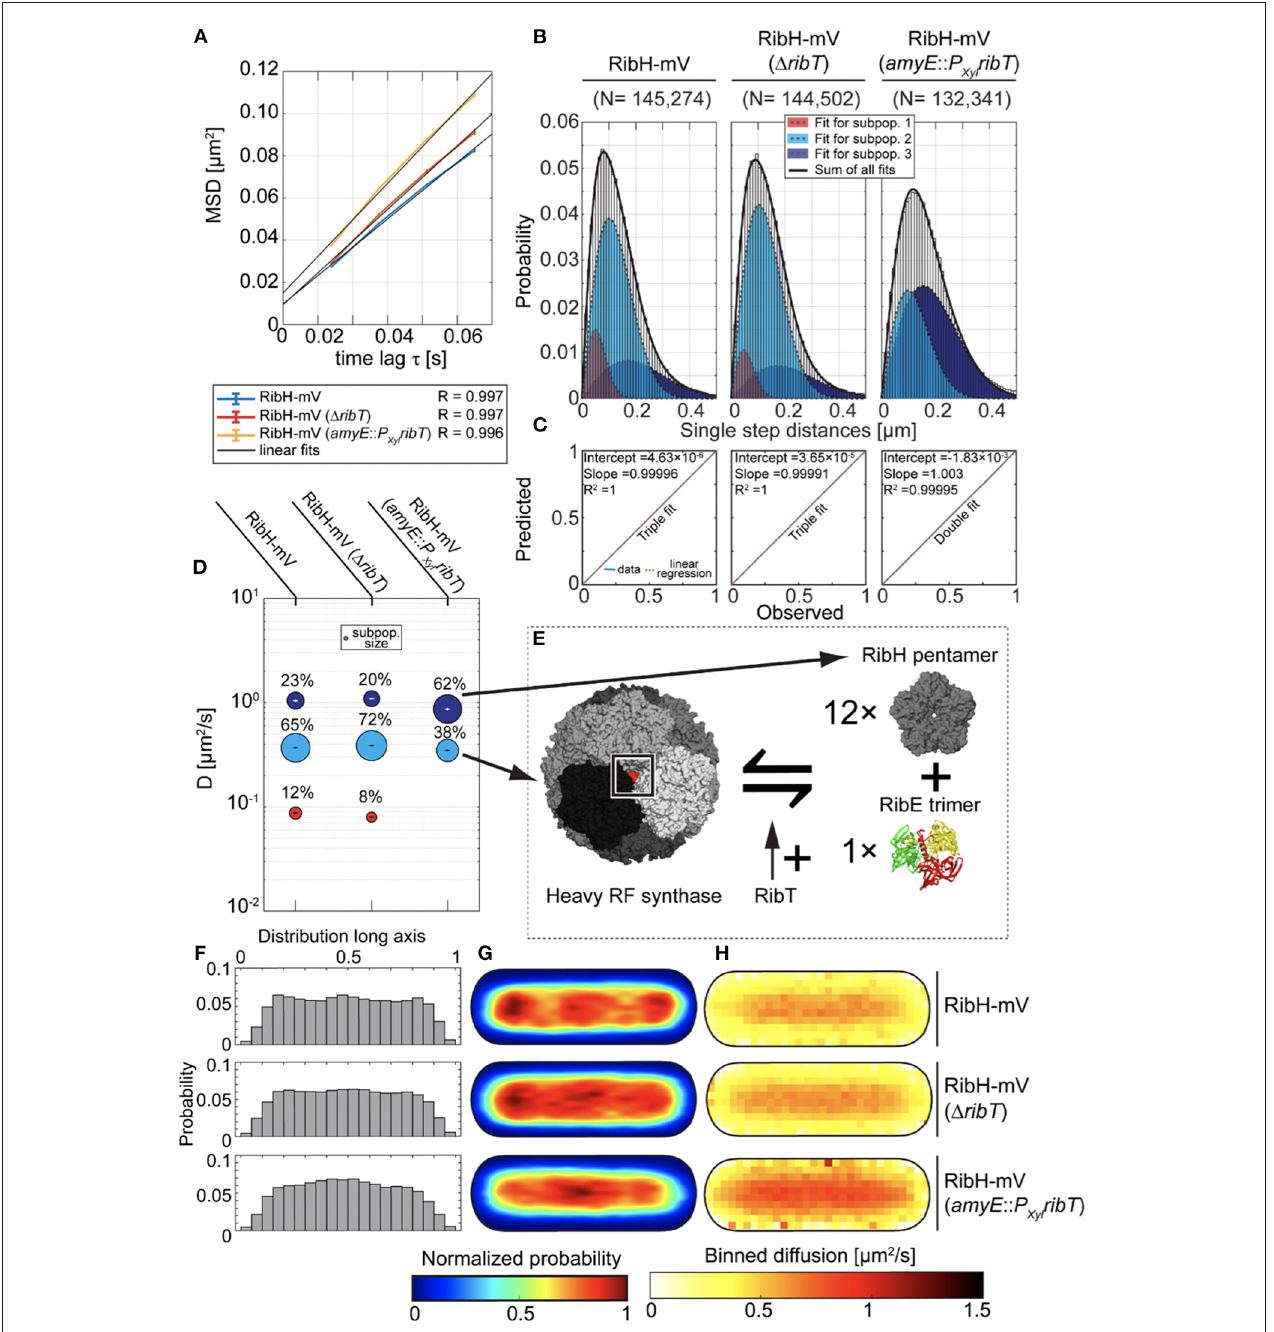
FIGURE 3 | Production of RibT from an ectopic locus in B. subtilis induces changes in diffusion of RibH-mV. (A) EAMSD vs. the time plot for three strains carrying RibH-mV either in the presence of ribT gene expressed from original locus (RibH-mV), or with ribT gene being deleted from the nucleoid (RibH-mV, 1 ribT ), or with ribT gene being expressed from an inducible, ectopic gene locus (RibH-mV, amyE :: P Xyl ribT ). (B) JD analysis of RibH-mV and RibH-mV ( 1 ribT ) SPT data using a three-component Rayleigh Mixture model, as well as RibH-mV ( amyE::P Xyl ribT ) using a two-component Rayleigh Mixture model. (C) Model prediction vs. observation plots for the Rayleigh Mixture models of JDs in (B) . (D) Bubble plots displaying relative proportions of subpopulations for the three strains with RibH-mV analyzed and their according DCs that are derived from JD analysis in (B) . (E) A model explaining how RibT is thought to affect the equilibrium between fully assembled capsids and free pentamers. (F) Histograms displaying the normalized probabilities of finding trajectories along the long axis of cells for the three different strains. (G) Spot location heat-maps displaying the spatial distributions of trajectories for the three different strains carrying RibH-mV. Trajectories were projected onto the two-dimensional cytoplasmic area of a normalized cell, which resembles an averaged sized cell of B. subtilis in the mid-exponential growth phase (1 µ m × 3 µ m). The likelihood of finding trajectories at a certain place in the cytoplasm is indicated by a color code from blue to red (indicated below the cell maps). Signal intensities of spatial distribution maps have been normalized with each other. (H) Speed-map representations of RibH-mV displaying the spatial distributions of single-step diffusion binned over areas of 0.1 µ m 2 for normalized cells. The color code (from white to red) indicating the values for binned diffusion is given below the speed-map representations.